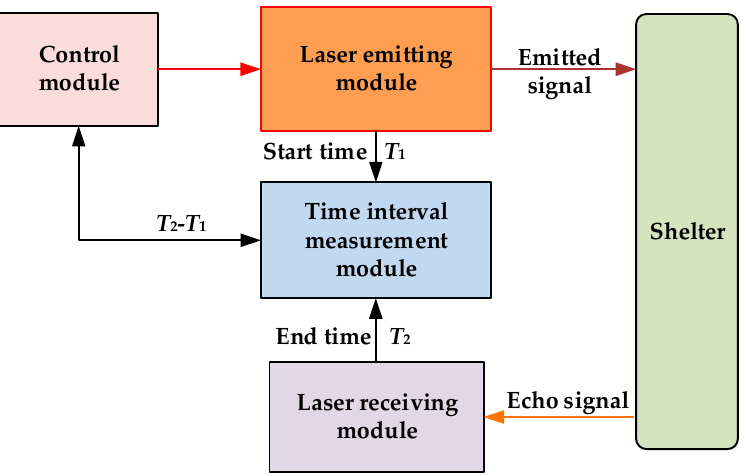
Figure 1. Laser ranging module: ( a ) the internal structure of the VL53L0X laser ranging sensor mod ‐ ule; ( b ) schematic diagram.